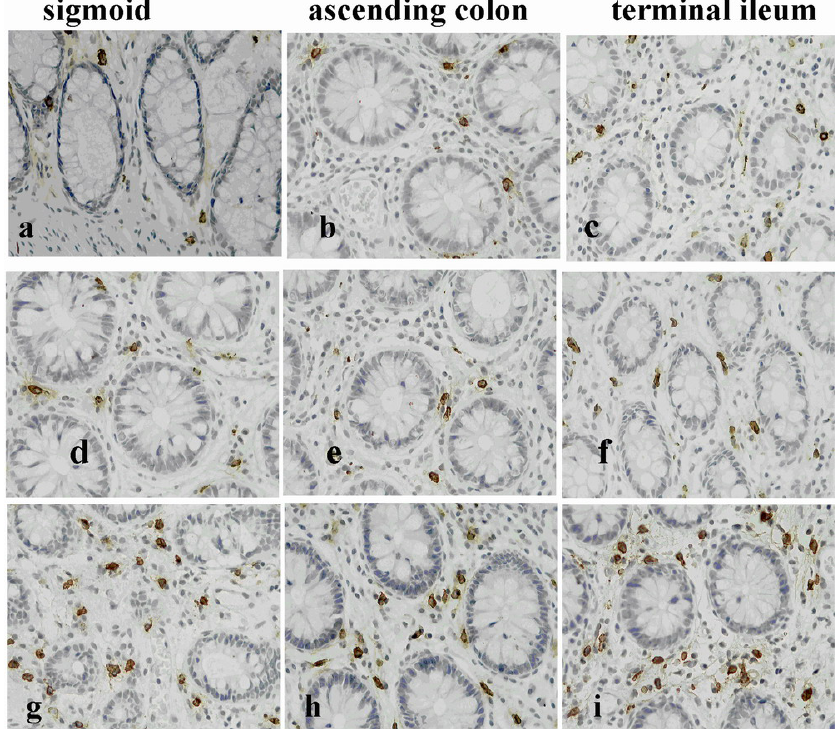
Figure 4. Representative photomicrographs showing tryptase positive mast cells (MCs) in the colonic mucosa of a healthy control (HCs) ( a – c ); an diarrhea predominant irritable bowel syndrome (IBS-D) patient with lactose malabsorption (LM) ( d – f ) and a patient with lactose intolerance (LI) ( g – i ). IBS-D patients with LI had increased mucosal MCs compared with